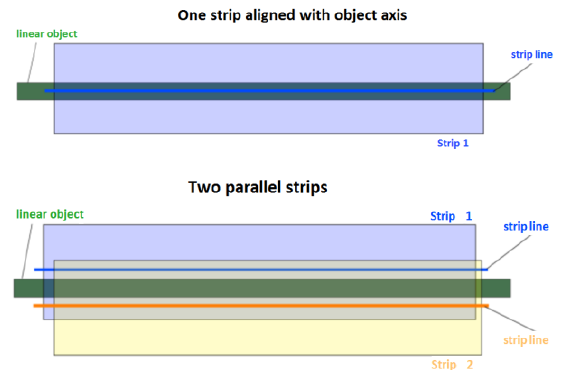
Figure 4. The applied variants of flights along levees: with one strip and with two strips of